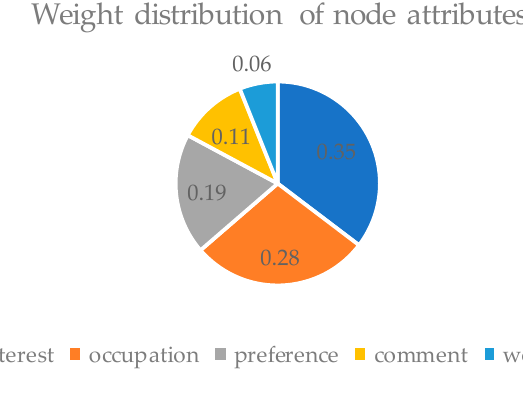
Figure 4. Weight value distribution of node social attributes.